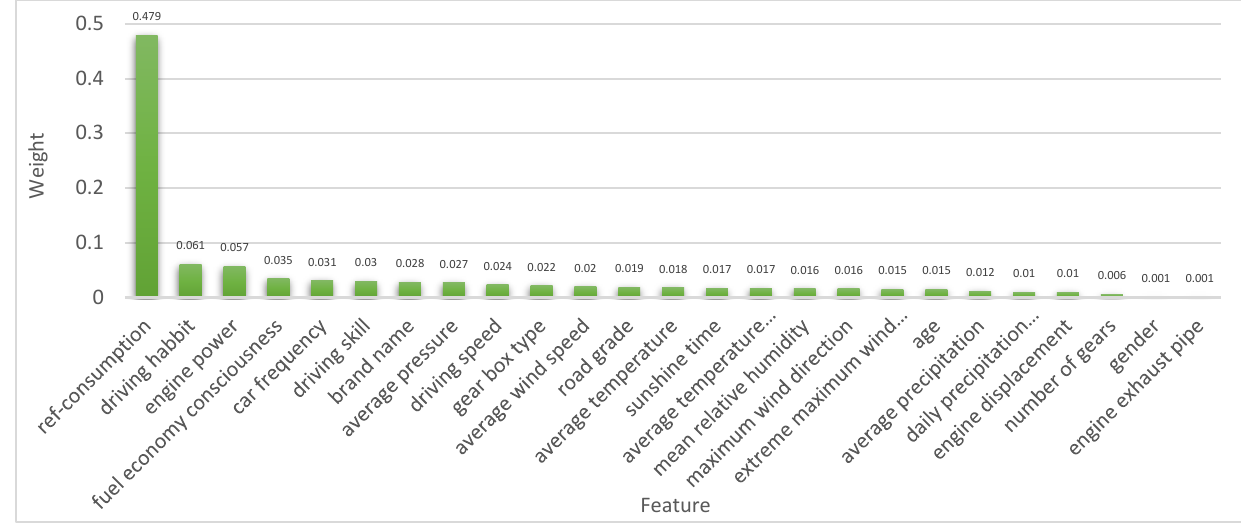
Figure 3. Weights of 25 factors in the random forest model.